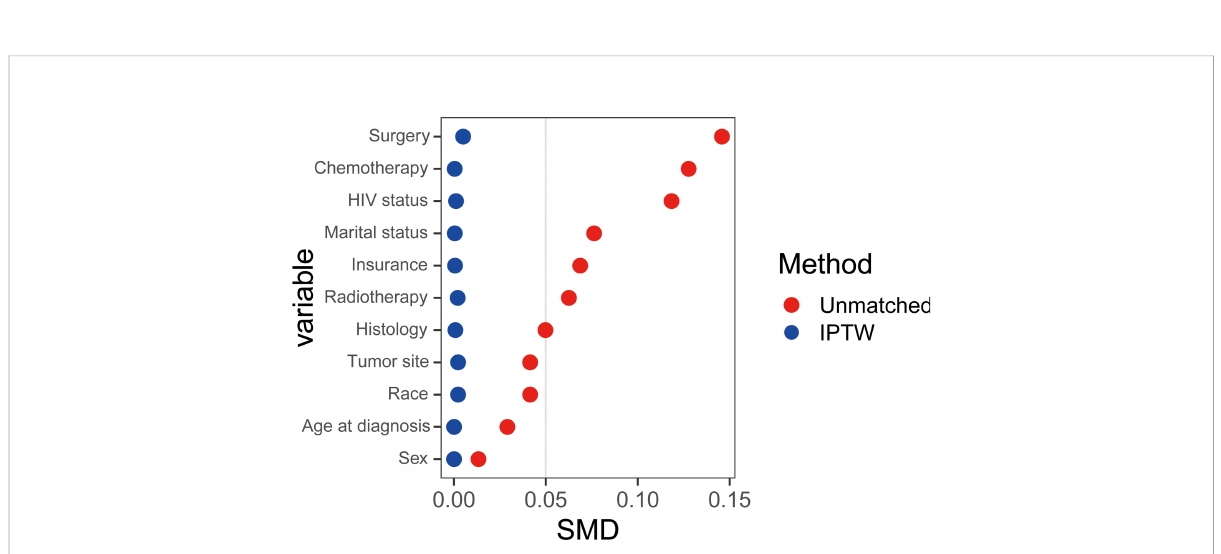
FIGURE 2 The absolute Standardized Mean Differences (SMDs) were calculated to verify the covariate balances after the IPW adjustment and a difference of SMD equal to zero indicates ideal balance.